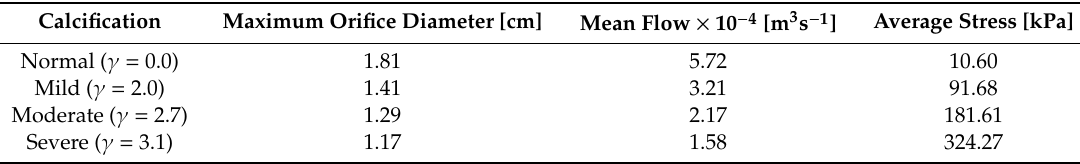
Figure 5. Volumetric blood flow with respect to γ . Table 2. Parameters for determining severity of calcification.